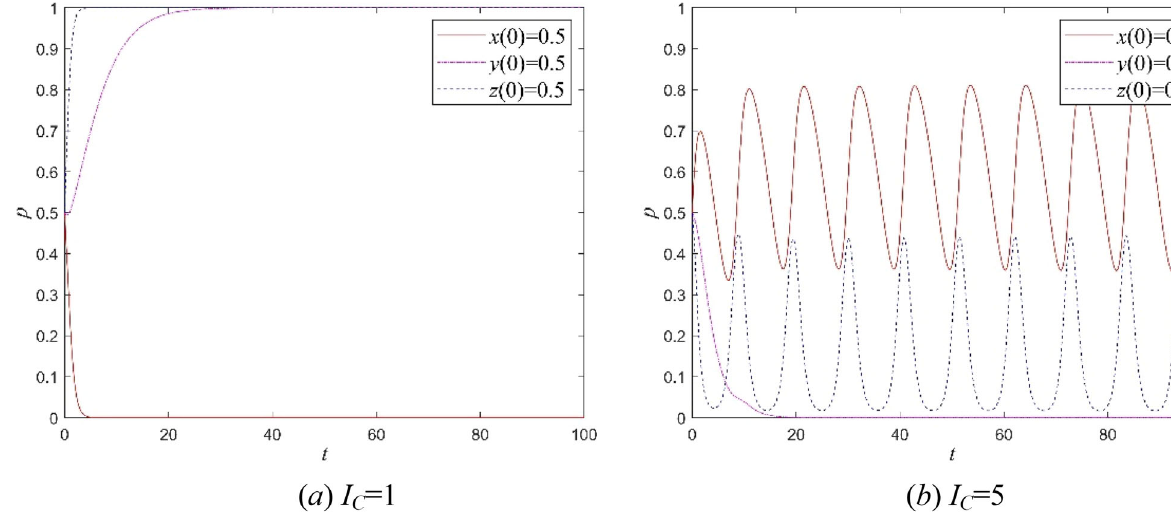
Fig. 7 ( a ) R H (cid:2) 16, ( b ) R H (cid:2) 25